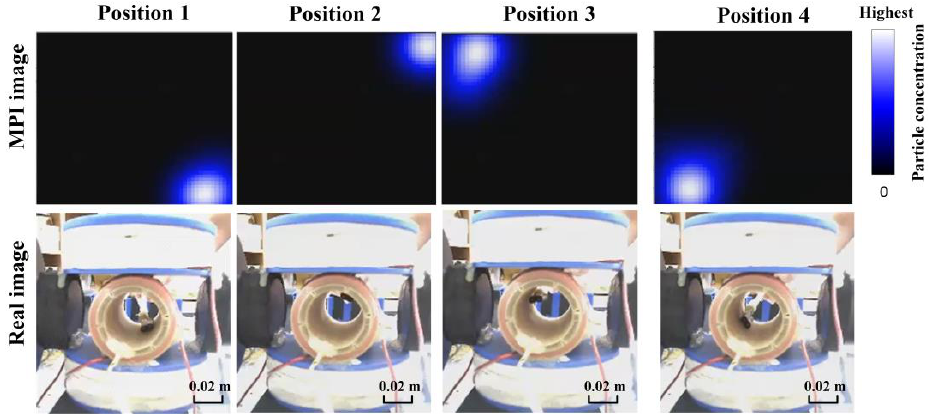
Figure 7. The Real-time 2D MPI image generation for tracking MNPs in the targeted drug delivery platform. The white color represents the maximum particle concentration and the black color shows the absence of particles.